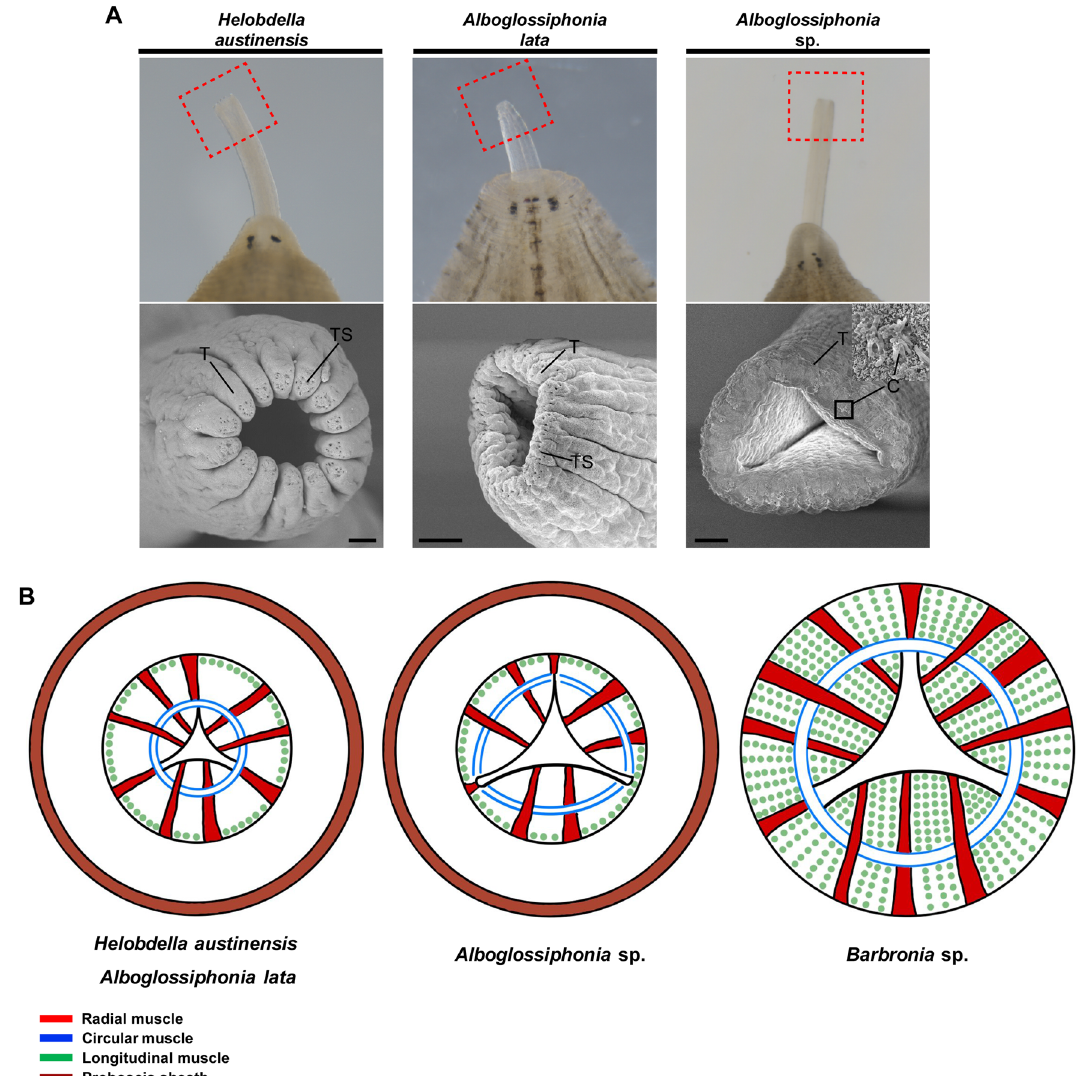
Figure 4. Apical structure of proboscis in glossiphoniid leeches and simplified schematics of muscle structure organization. ( A ) SEM images of proboscis tips (red dotted square) show that the tips of the proboscises of fluid-sucking species are contracted, whereas the tip of the proboscis of Alboglossiphonia sp. is broad and uncontracted. Numerous cilia bundles (black square) are visible at the tip of the proboscis in Alboglossiphonia sp. T tip of proboscis; TS secretion pore of proboscis tip; C cilia. Scale bars 20 μm. ( B ) Schematics of comparative muscle structure organization in leech feeding organs. Fluid ingestion leeches have compartmentalized muscle layers, with a distinct ring of circular muscles surrounding the proboscis cavity and radial muscles extending from inner to the outer region of the proboscis. In contrast, Alboglossiphonia sp. has three sets of separate circular muscles, radial muscles, and an expanded lumen within the proboscis. The esophagus of Barbronia sp. is surrounded by circular muscles with radial muscles extending throughout the body, well-developed inner radial muscles, and a lumen that expands to the circular muscle